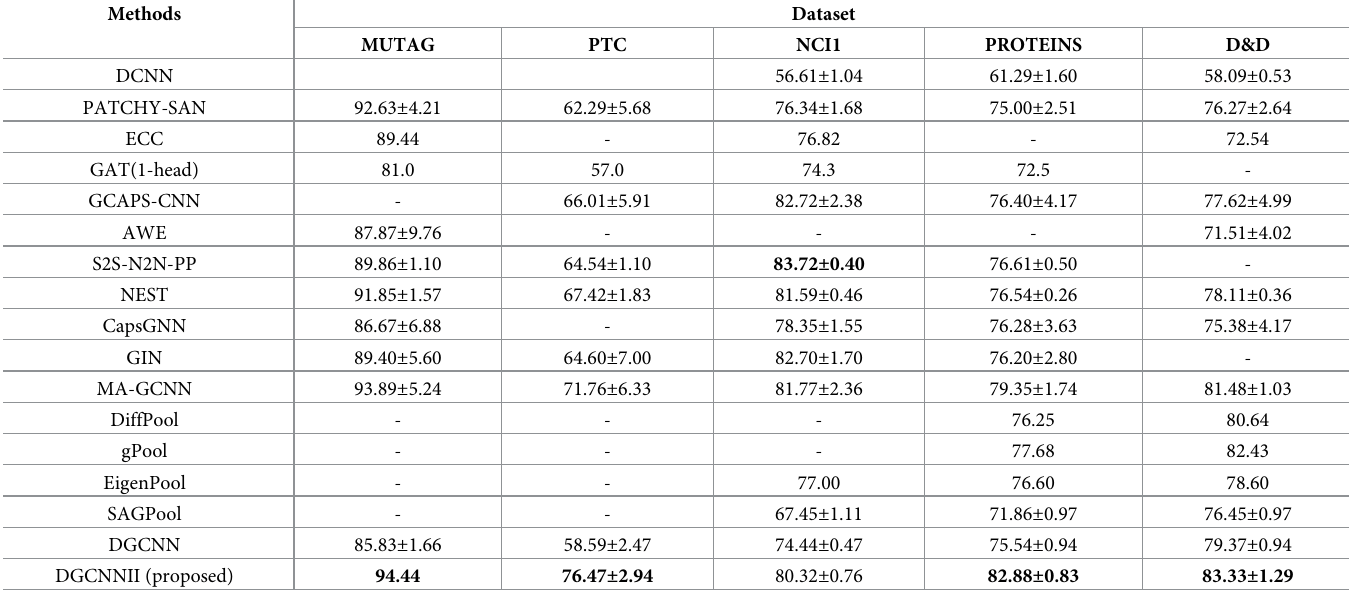
Table 5. Comparison of graph classification accuracy with other graph neural network based methods.